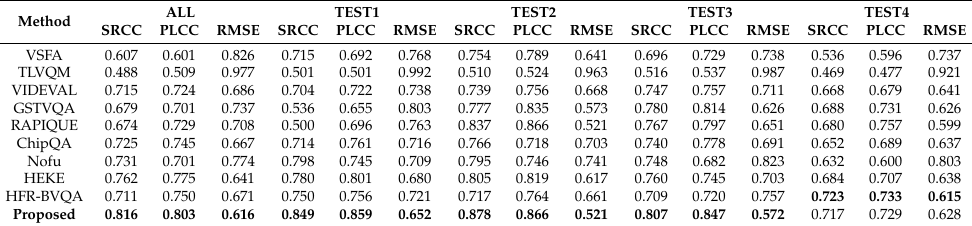
Table 2. Performance comparison on the AVT-VQDB-UHD-1 databases.